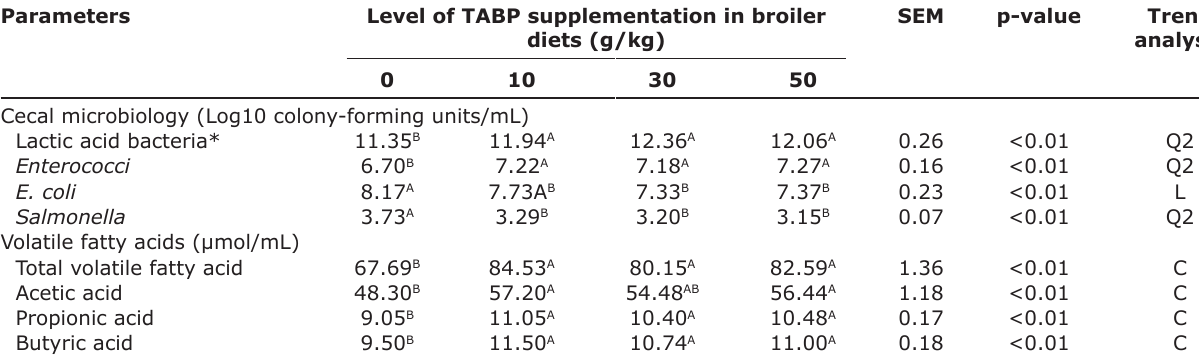
Table-4: Effects of TABP supplementation in broiler diets on cecal microbiota and volatile fatty acids content. Parameters